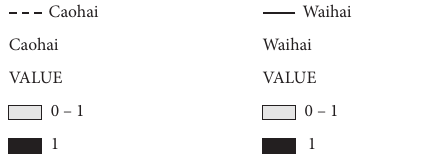
Figure 7: Location of sampling sites in Dianchi Lake.